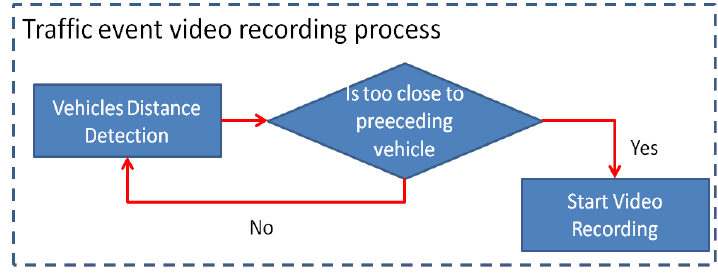
Figure 8. Traffic event video recording process work